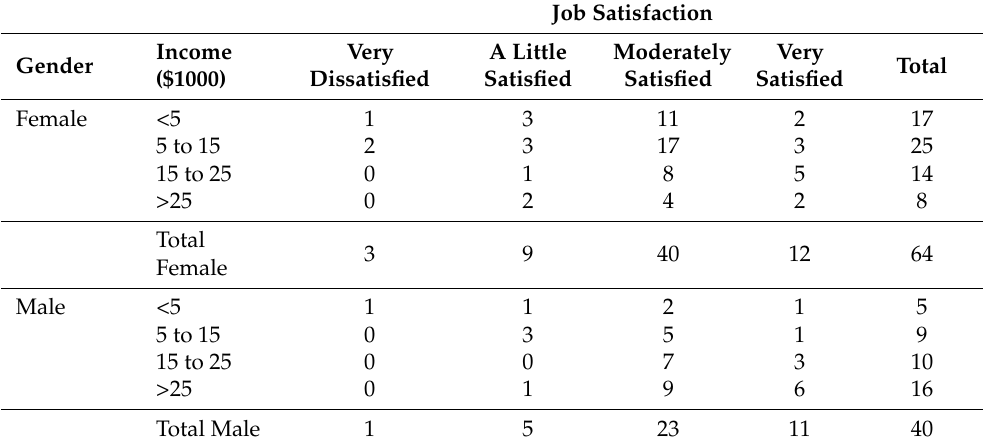
Table 1. Satisfaction and income in males and